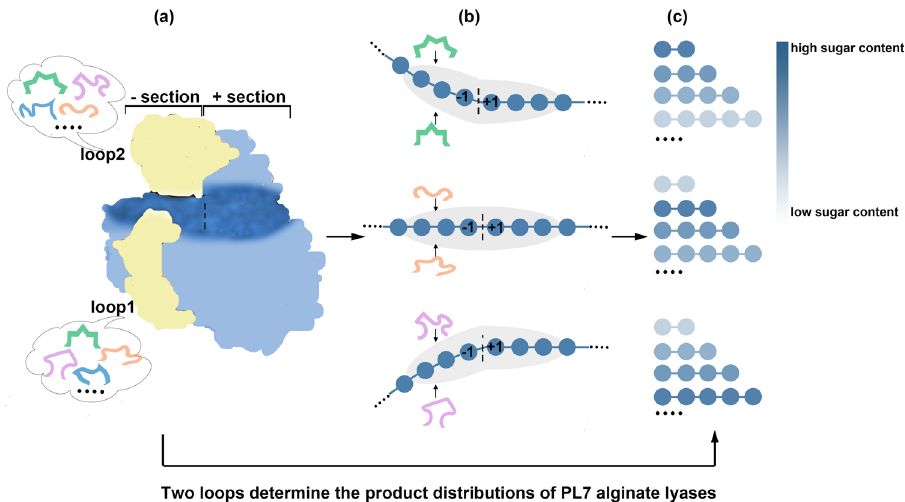
Fig. 6 The relationship between two loops, the substrate binding pro fi le and product distribution. The monomer unit of alginate is shown in a blue circle. The endolytic PL7 alginate lyase a degraded long-chain alginate b into a mixture of oligosaccharides with different Dps c . The oligosaccharides are colored with a gradient from white (low sugar content) to blue (high sugar content), indicating different product distributions. Our study demonstrated that the “ + ” sections of the substrate binding clefts of PL7 alginate lyases contained several conserved residues, leading to similar substrate binding pro fi les. In contrast, the “ - ” sections of the substrate binding clefts exhibited diversity, resulting in different substrate binding pro fi les. Thus, the overall substrate binding pro fi les of PL7 alginate lyases were mainly determined by the “ - ” sections. Structural and biochemical analyses indicated that the diverse substrate binding pro fi les were attributed to the different loops (loop1 and loop2) around the “ - ” section. Accordingly, these two loops determined the substrate binding pro fi les of PL7 alginate lyases. Because the substrate binding pro fi le directly in fl uenced the product distribution, we associated the two loops with the product distributions. Thus, two loops in the “ - ” section determined product distributions. Table 2 The loop sequences of eight PL7 alginate lyases with solved structures.